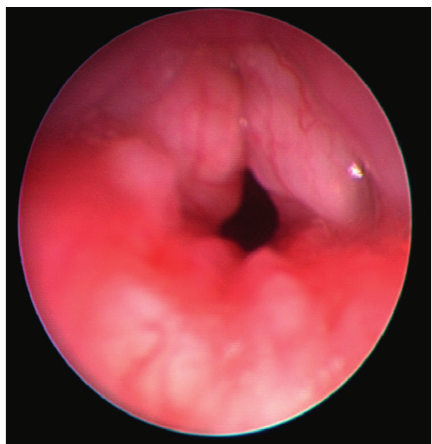
Figure 3: Bronchoscopic view of the supraglottic area showing the laryngeal nodular formation and